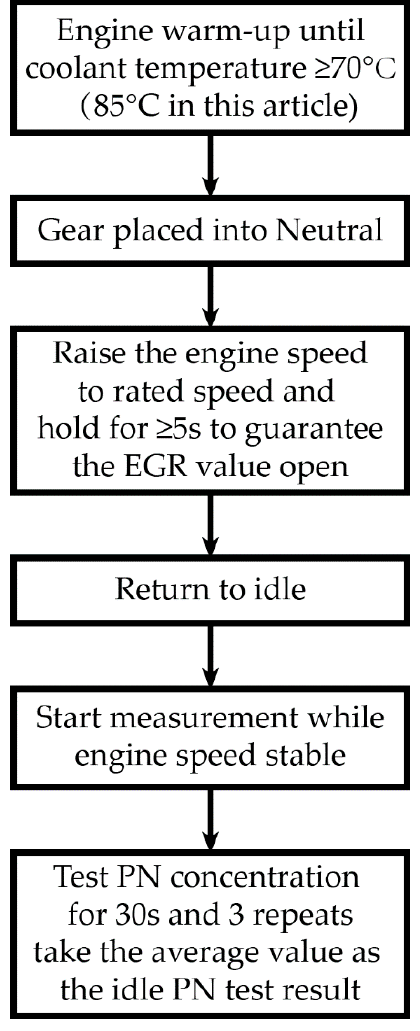
Figure 3. Procedures of idle PN